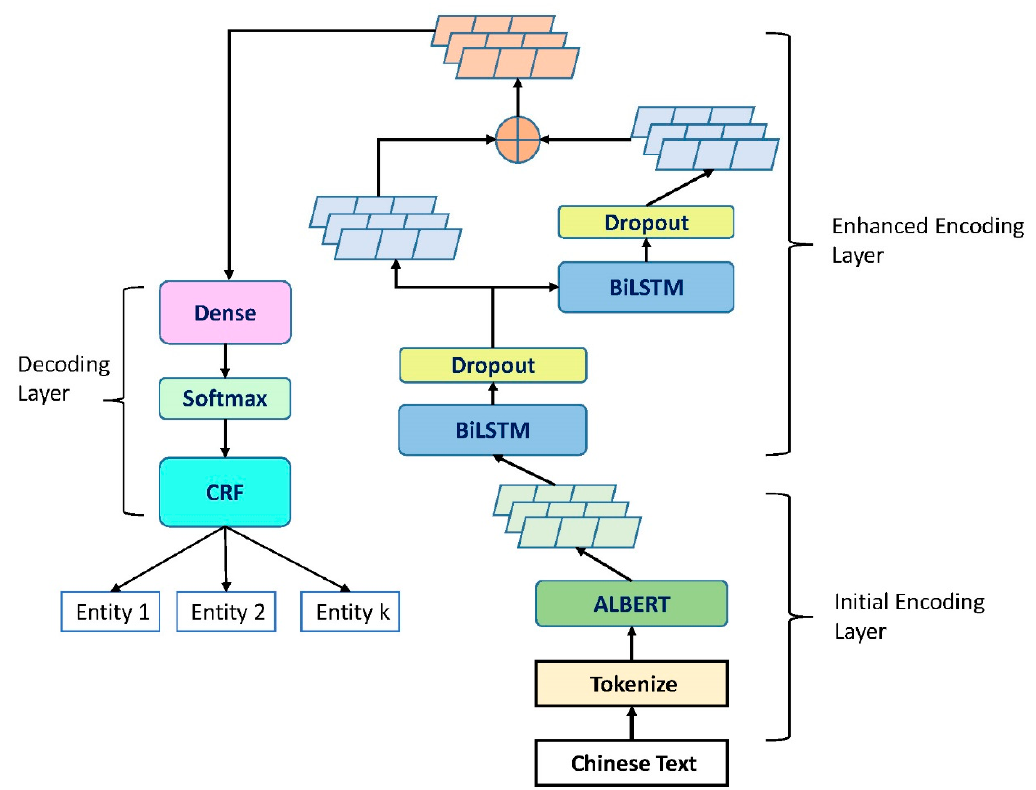
Figure 1. The basic framework of our En2BiLSTM-CRF model. It shows the main process of fine- grained entity